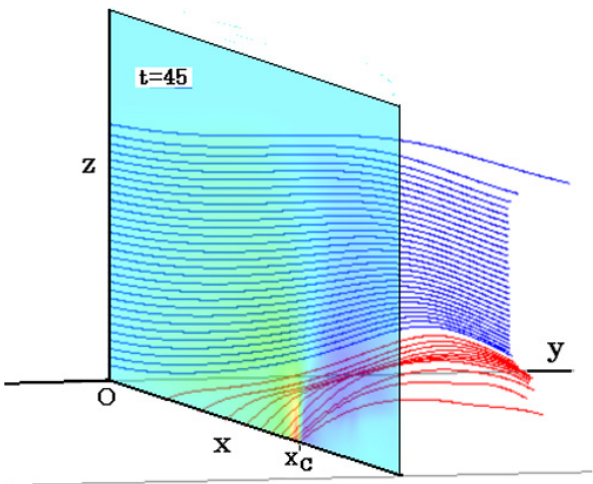
Fig. 7. Magnetic field lines passing through the z-axis (blue) and the reconnected field lines passing through the x-axis (red), and dis- tribution of B z in color in the y = 0 [ (x,z) ] plane, at t = 45 for the case of B y0 = 0 . 1 and α = 0 . 1, where X C indicates the plasmoid